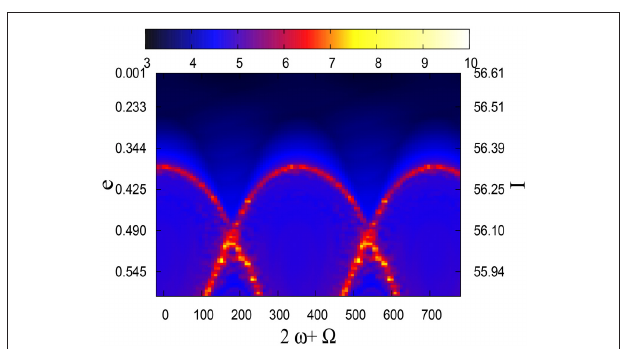
FIGURE 6 | FLIs for the model c, for a = 15 , 000 km, (cid:127) = 180 ◦ and T = 0.03 .